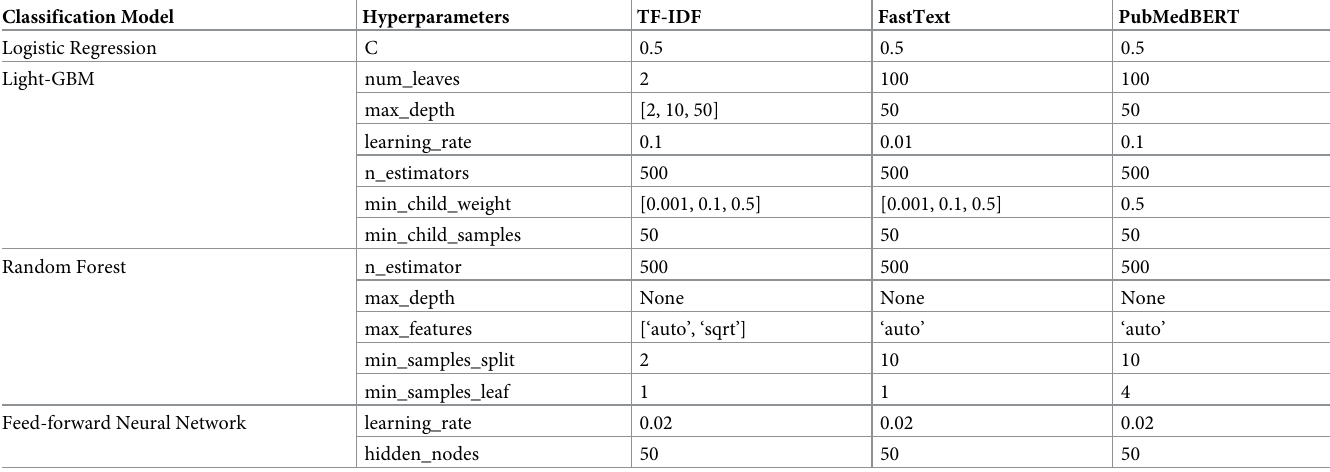
Table 2. Hyperparameter optimization for classification